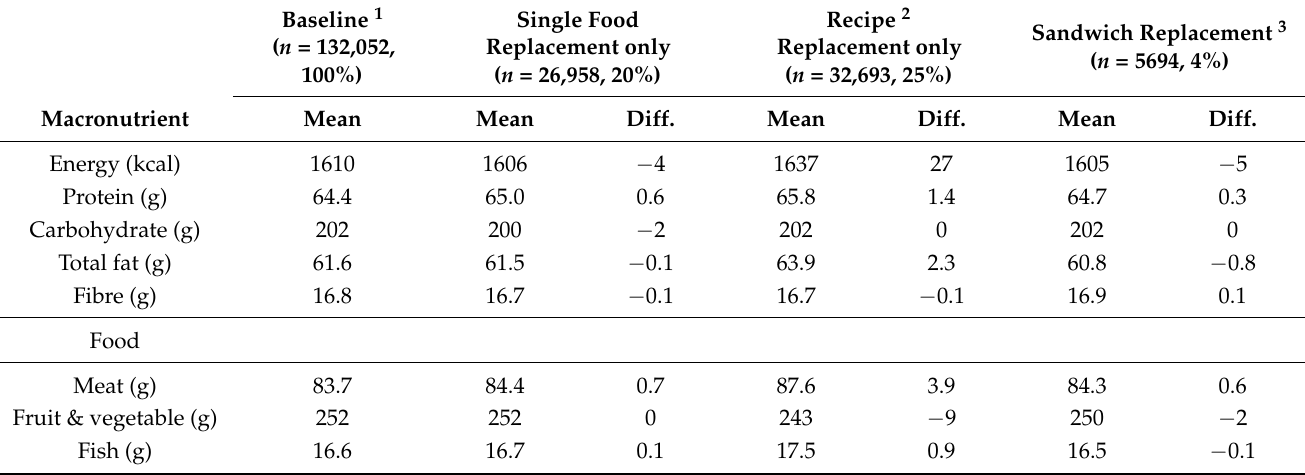
Table 1. Differences in the mean daily intakes of energy, macronutrients and selected foods from food sources (excluding nutritional supplements) in NDNS year 2017 respondents ( n = 1211)